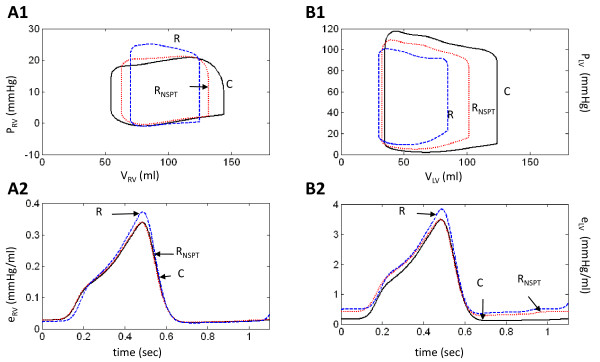
Model Ventricular Function Curves - Septal Stiffness Comparison. Simulated ventricular function curves of normal physiology (control, C), increased LV wall and septal stiffness (R), and increased LV wall but normal septal stiffness (RNSPT). All simulations performed with normal systolic contractility.